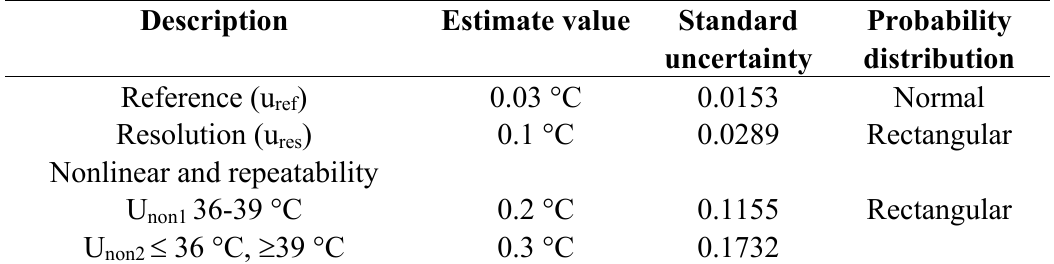
Table 5. The type B uncertainty analysis for OMRON MC-510 thermometer.